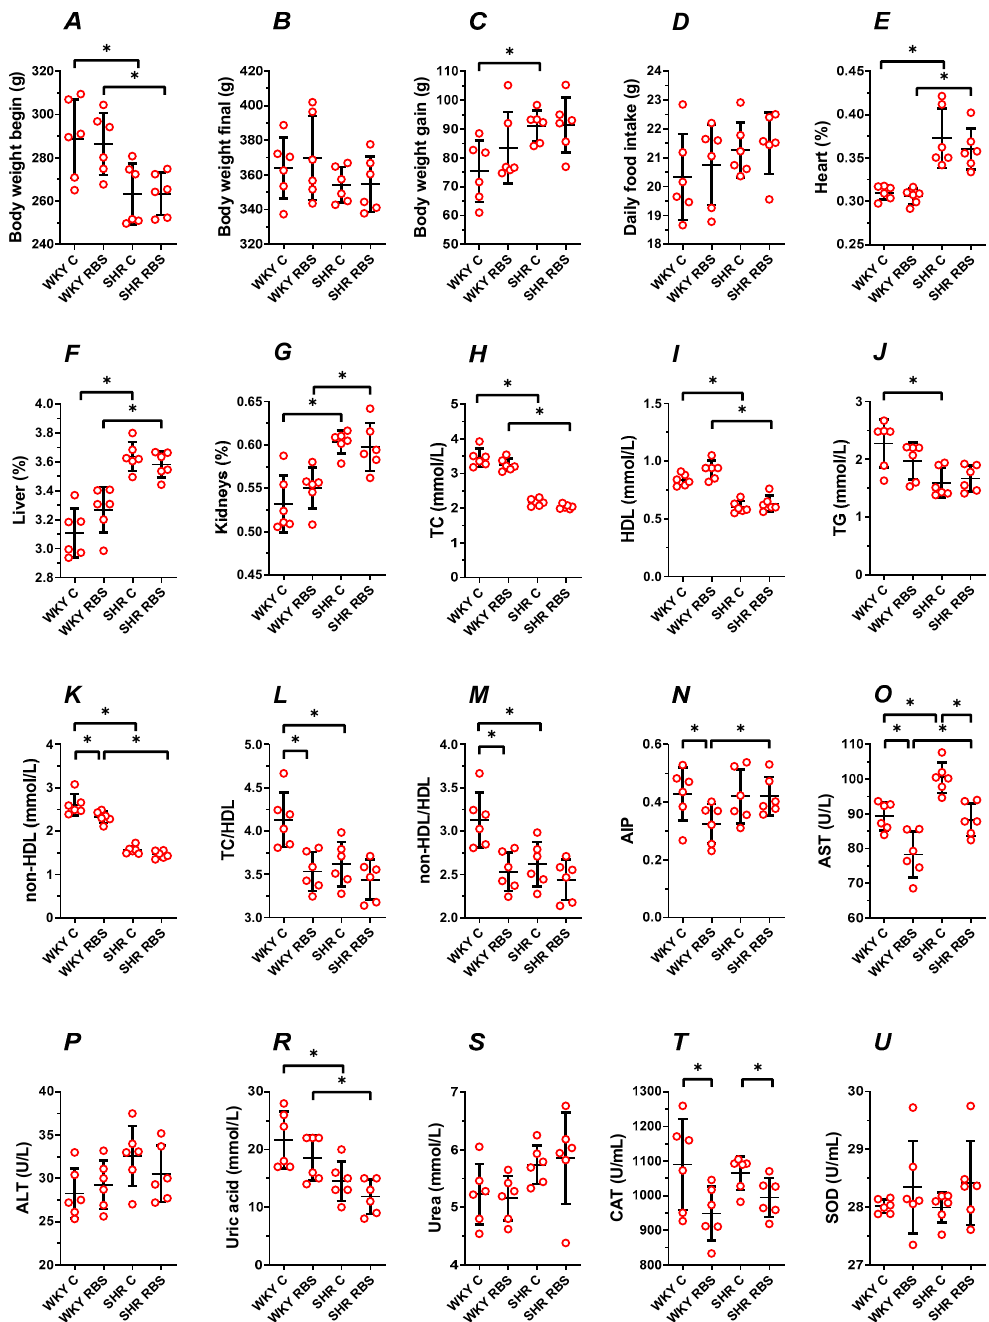
Figure 1. The influence of experimental diets on rat body weight ( A – C ), daily feed intake ( D ), weight of internal organs ( E – G ), the traditional lipid profile ( H – J ), the nontraditional lipid profile ( K – N ), liver enzymes ( O , P ), uric acid ( R ), urea ( S ), and antioxidant status ( T , U ). From 10 weeks of age, Wistar–Kyoto rats (WKYs) and spontaneously hypertensive rats (SHRs) were fed for 6 weeks with a diet enriched with 7% ground raspberry seeds (RBS). Values are expressed as mean ± SD, n = 6, * p ≤ 0.05 (ANOVA/Tukey’s).